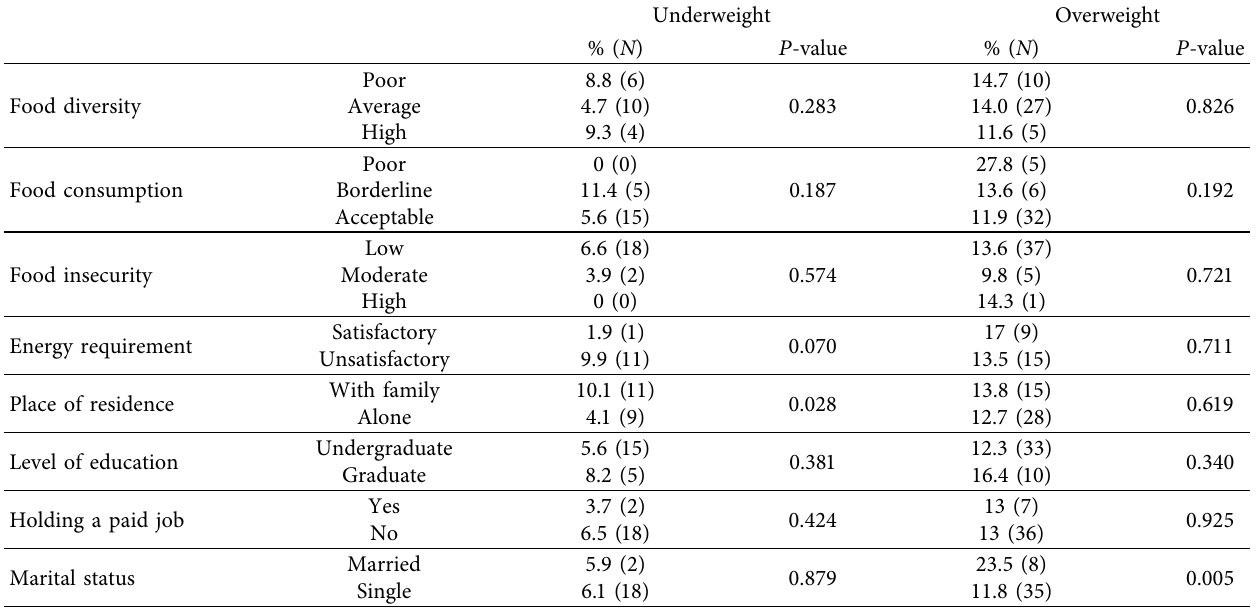
Table 9: Assessment of factors influencing the nutritional status of students of the University of